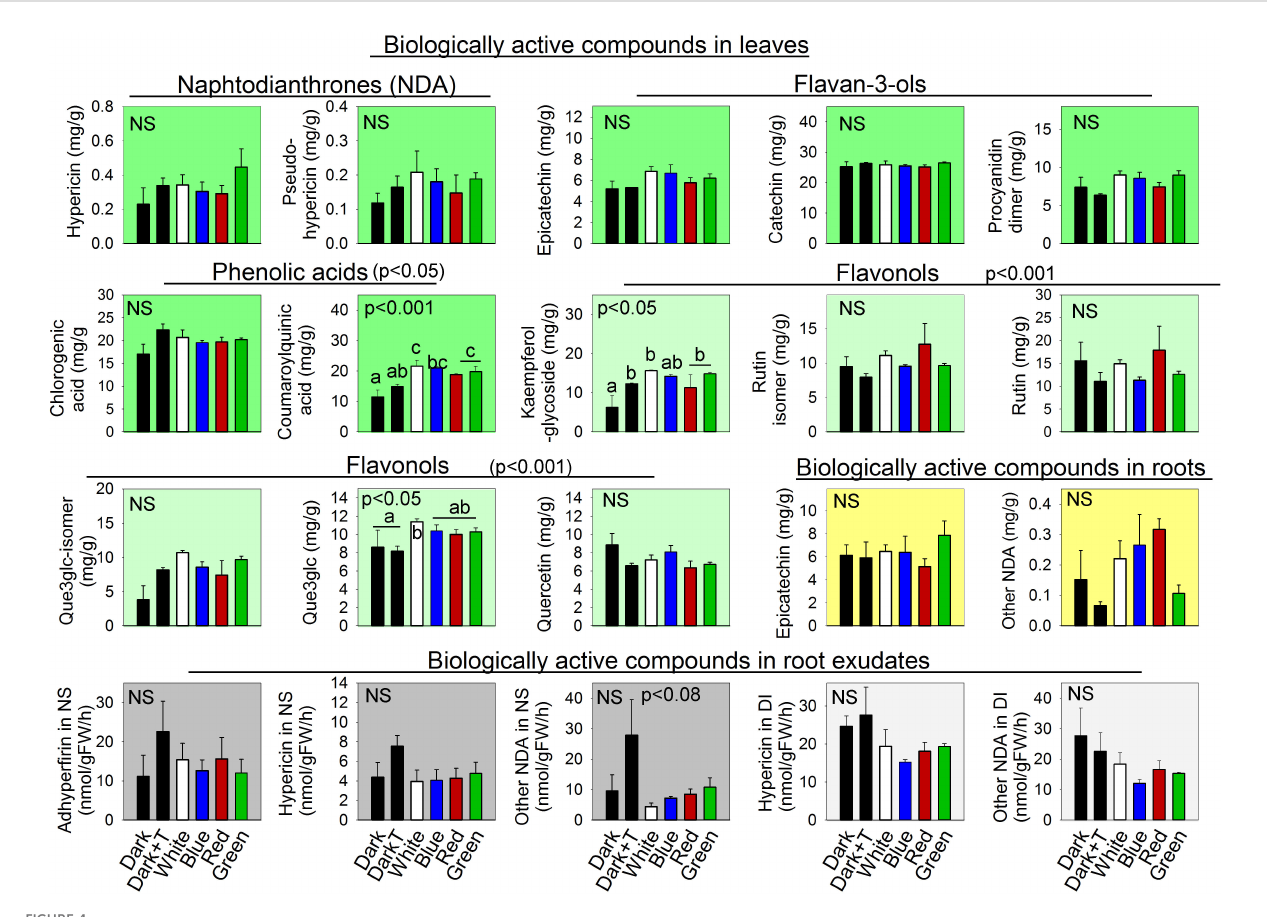
FIGURE 4 The in fl uence of different light spectra and increased temperature of the nutrient solution on the concentration of biologically active compounds in leaves and roots and on the rates of root exudation of those compounds in Hypericum perforatum cultivated in an aeroponics system. Values are means ± SE. NS is not signi fi cant at the 0.05 level probability test (one-way ANOVA) ( n=4 ). The data were analyzed using the LSD test. Differences between means with different letters are statistically signi fi cant at the 0.05 probability level. Abbrev.: naphtodianthrone